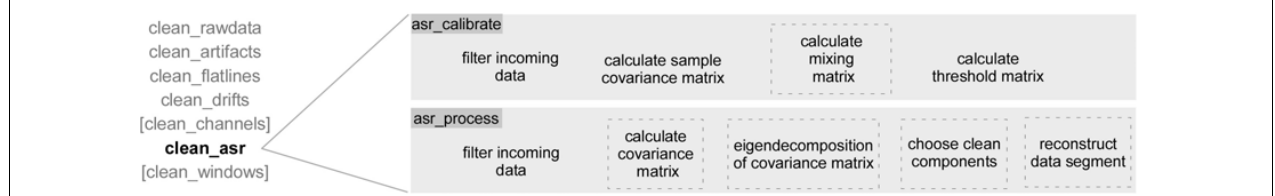
FIGURE 1 | The EEGLAB toolbox methods are listed on the left (in gray) and include the two core functions of ASR and rASR that are called by the function clean_asr . Parts of the algorithm that were adapted using geometry-aware methods are marked by dashed sections. The toolbox consists of several preprocessing and correction functions that together comprise artifact correction for multi-channel EEG data. Some of the functions marked in square brackets are computationally expensive and profit from many data, but they are typically not used for online applications, we therefore refrained from using them herein. When using the toolbox, all functions are called once, clean_asr is then calling the calibration and subsequently the processing repeatedly with short segments of the uncorrected data. The procedure is the same for the online and offline use of ASR and rASR.